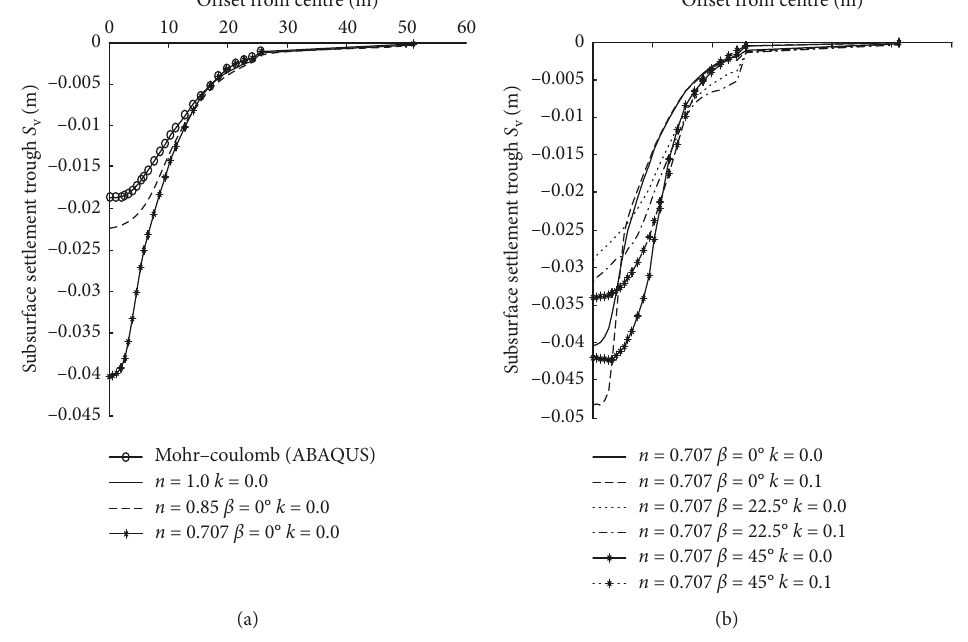
0.6); (b) soil anisotropy and non-coaxiality ( λ (cid:31)